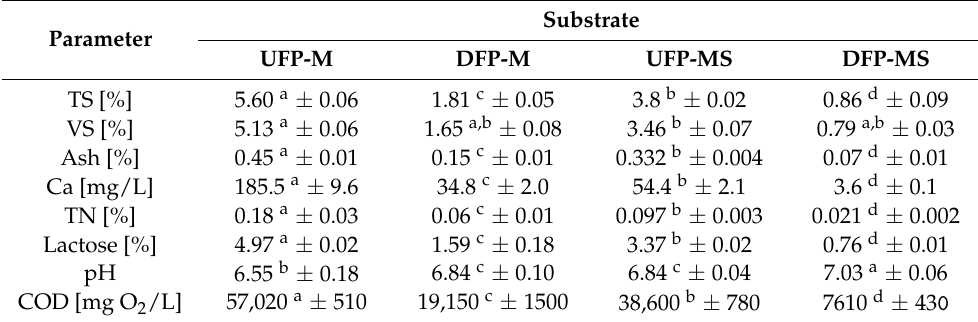
Table 2. The physicochemical parameters of the fermentation substrates.